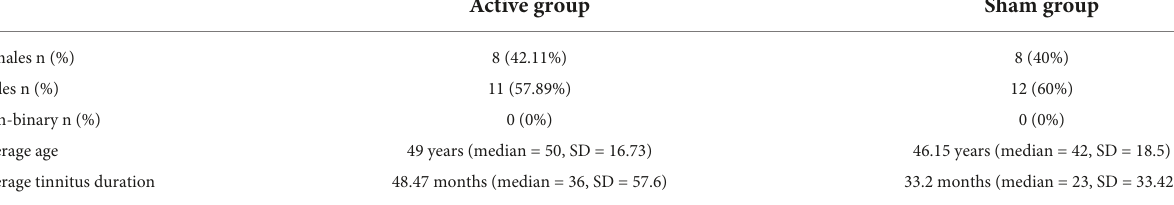
TABLE 1 Demographic data of the participants with respect to the research arm (SD = standard